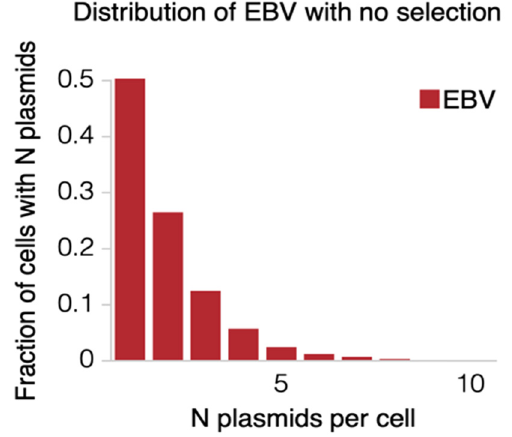
Figure 2. The distribution of the fraction of numbers of plasmids per cell in EBV is shown. This distribution was calculated from the findings of Nanbo et al. [1] following infection of primary B-cells with EBV at a multiplicity of infection of 2 after 50 generations of growth in culture. Not shown is the fraction of cells with zero plasmids per cell that die.